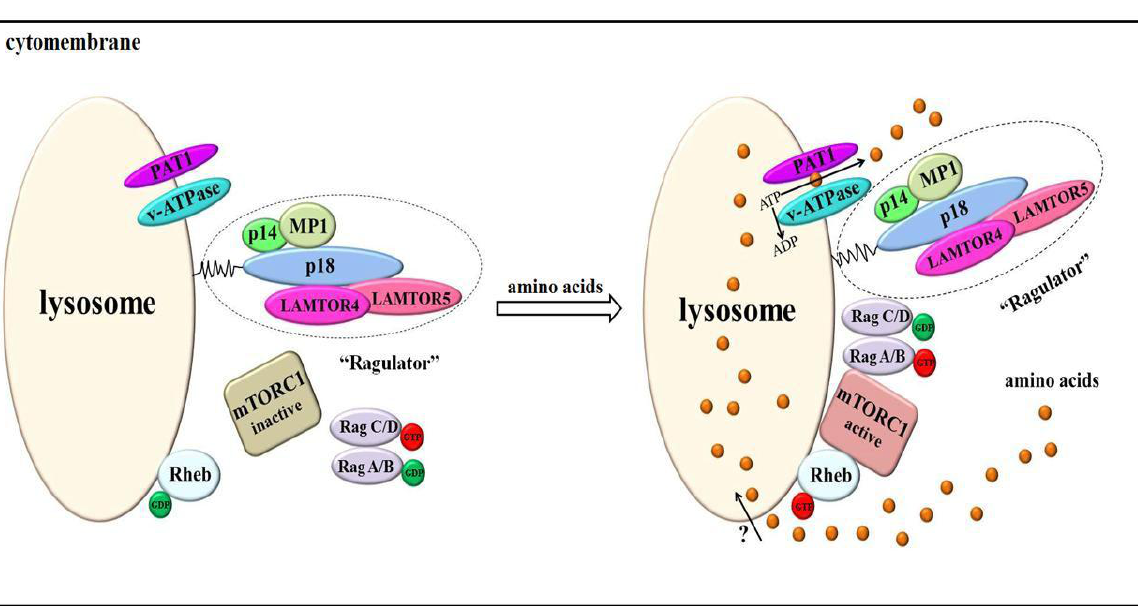
Figure 3. The “inside-out” model of mTORC1 activation by amino acids. Ragulator, PAT1, v-ATPase, and Rheb localize on the lysosomal surface. The amino acid signals in the lysosome are sensed by v-ATPase and PAT1, which actively export amino acids from the lumen to the cytosol and induce structural rearrangement of the v-ATPase-Ragulator-Rag GTPase by hydrolyzing ATP. This process activates the Ragulator and Rag GTPases, which colocalize mTORC1 to the lysosome to interact with active Rheb-GTP on the surface, initiating mTORC1